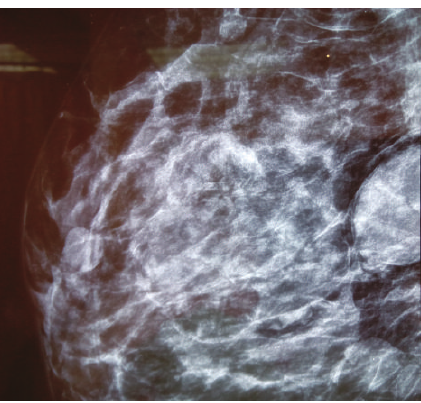
Figure 1: A 28 mm × 34 mm well-circumscribed mass at upper lateral quadrant of the right breast. There was no calcification.